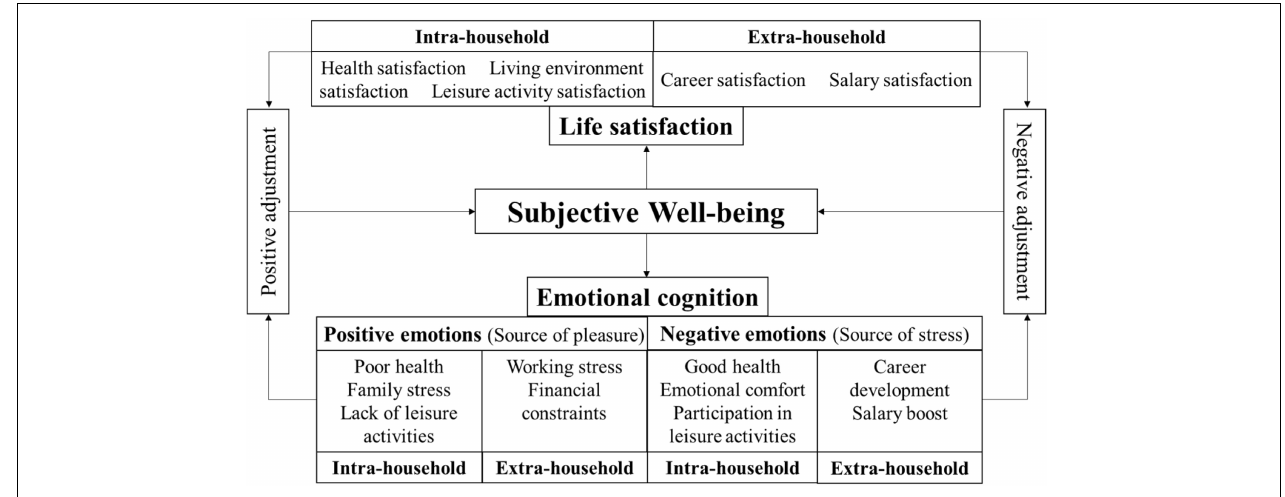
FIGURE 1 | The model construction of